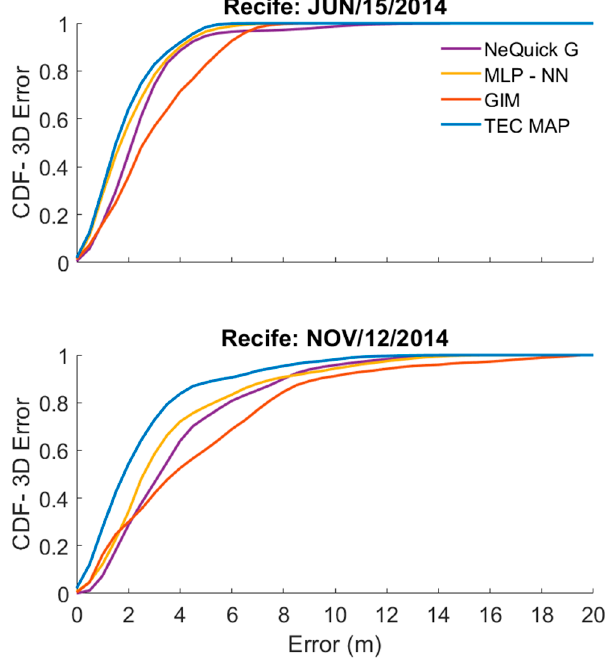
Figure 10. Empirical CDF of the SPP 3D error considering different ionospheric models for the station in Recife for the winter (15 June at upper panel) and summer (12 November at bottom panel) solstice conditions in 2014.